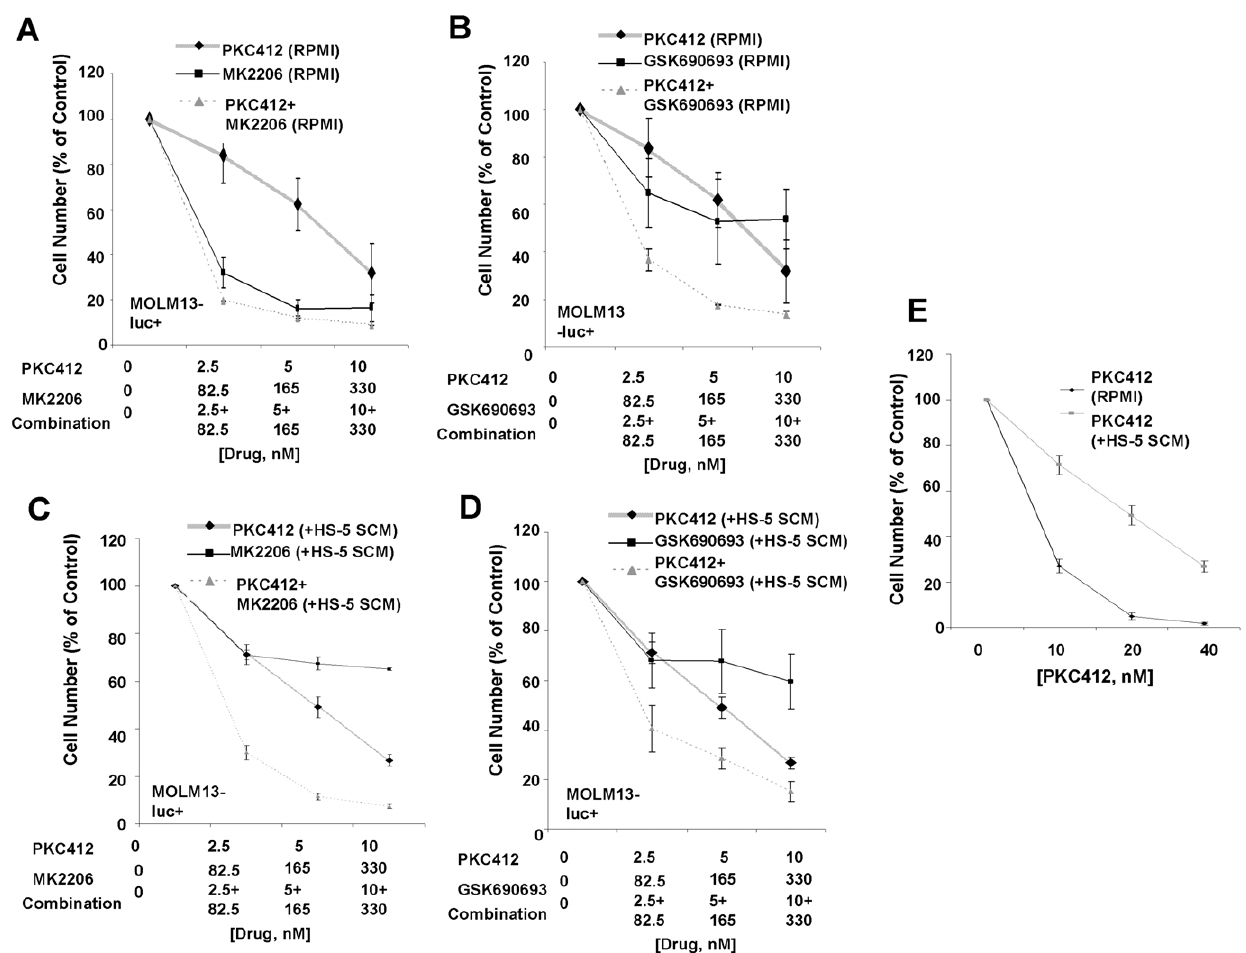
Figure 5. Selective inhibitors of AKT positively combine with PKC412 in the absence and presence of HS-5 SCM against MOLM13- luc + cells. (A–B) Approximately two-day proliferation studies performed with selective AKT inhibitors in combination with PKC412 in the presence of RPMI + 10% FBS. (C–D) Approximately two-day proliferation studies performed with selective AKT inhibitors in combination with PKC412 in 80% HS- 5 SCM. (E) Treatment of MOLM13-luc + cells with PKC412 in either RPMI + 10% FBS or 80% HS-5